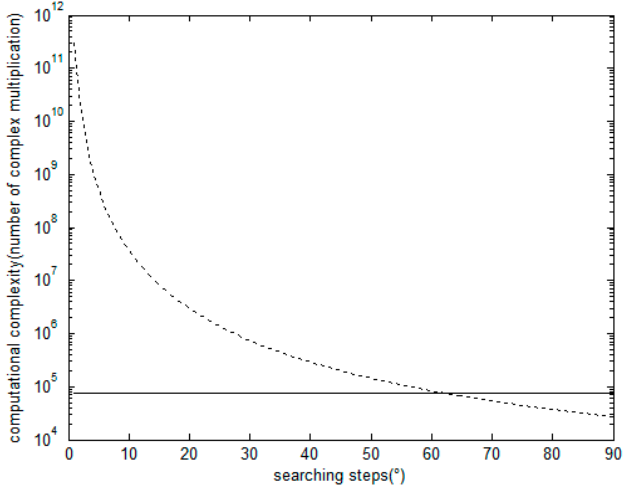
Figure 6. Computational complexity of the proposed algorithm and LV-MUSIC algorithm with respect to searching steps.